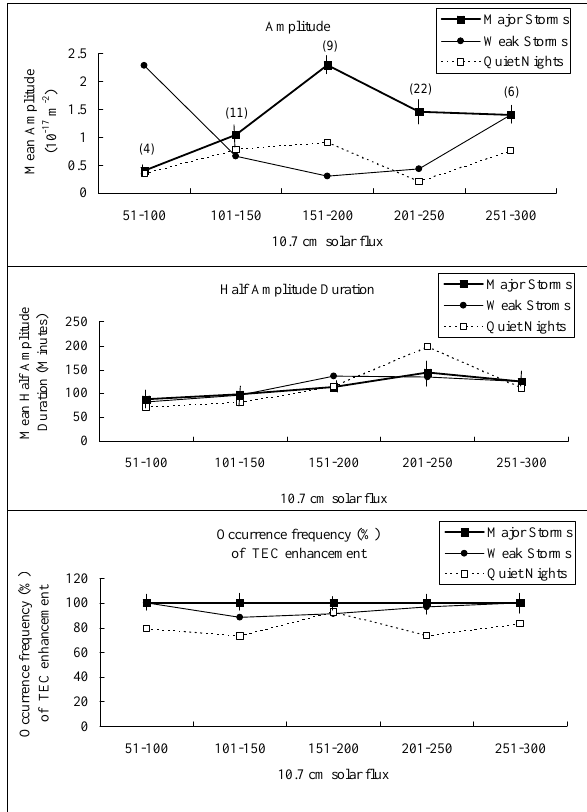
Fig. 5. Local time distribution of (a) the mean amplitude (b) mean half-amplitude and (c) the occurrence frequency (in percent) of TEC enhancement during weak storms and quiet nights.